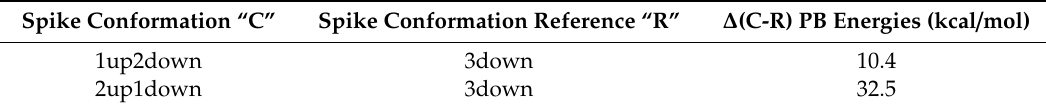
Table 2. ∆ G calculated by the Poisson–Boltzmann (PB) method at a pH of 7 and an ionic-strength of 150